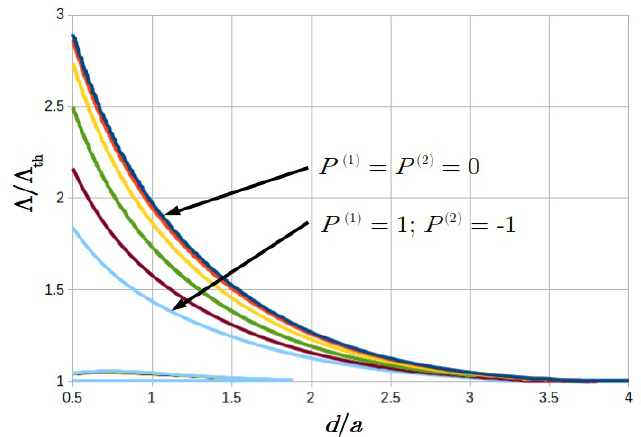
Figure 11. Stability boundary for pump ellipticity P ( 1 ) = 1 in guide ( 1 ) and varying P ( 2 ) in guide ( 2 ) from 0 to 1 in steps on 0.2.